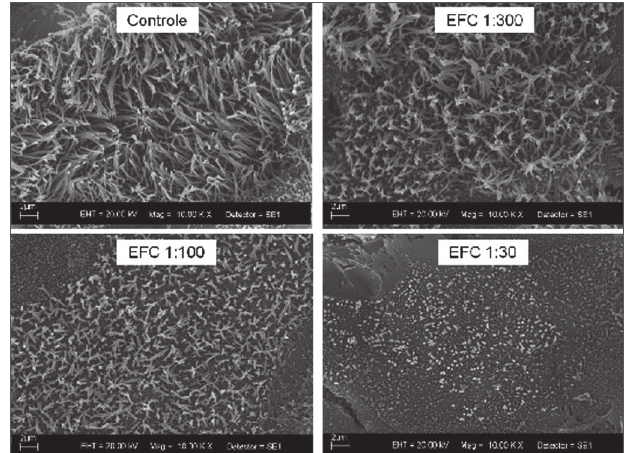
Figura 2. Fotografias de microscopia eletrônica de varredura demons- trando efeito dose-dependente da fumaça de cigarro sobre o tamanho dos cílios após exposição a diluições decrescentes de Extrato de Fumaça de Cigarro